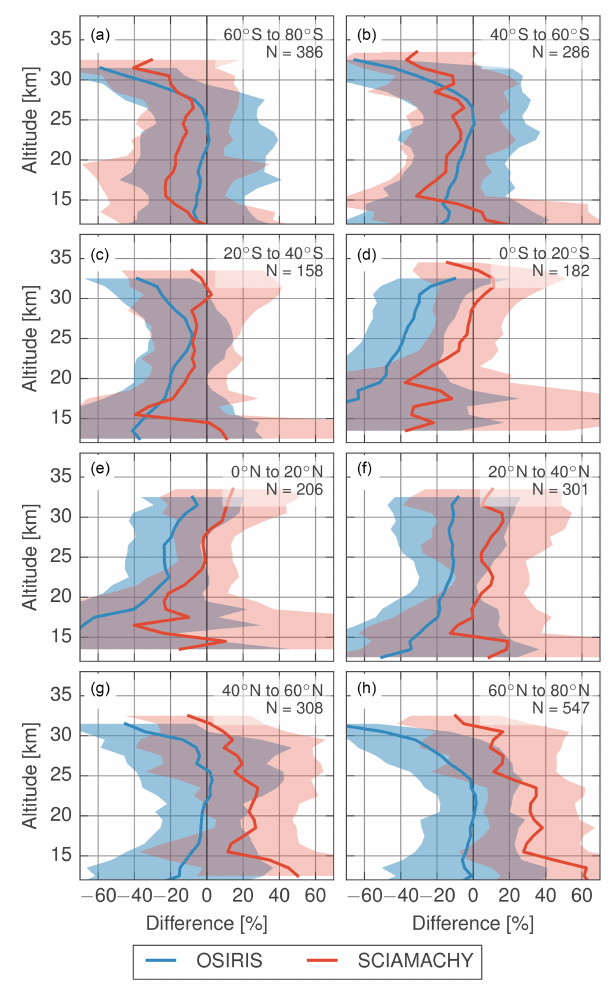
Figure 10. Coincident comparison with SAGE II when both OSIRIS and SCIAMACHY measurements have been processed with the IUP